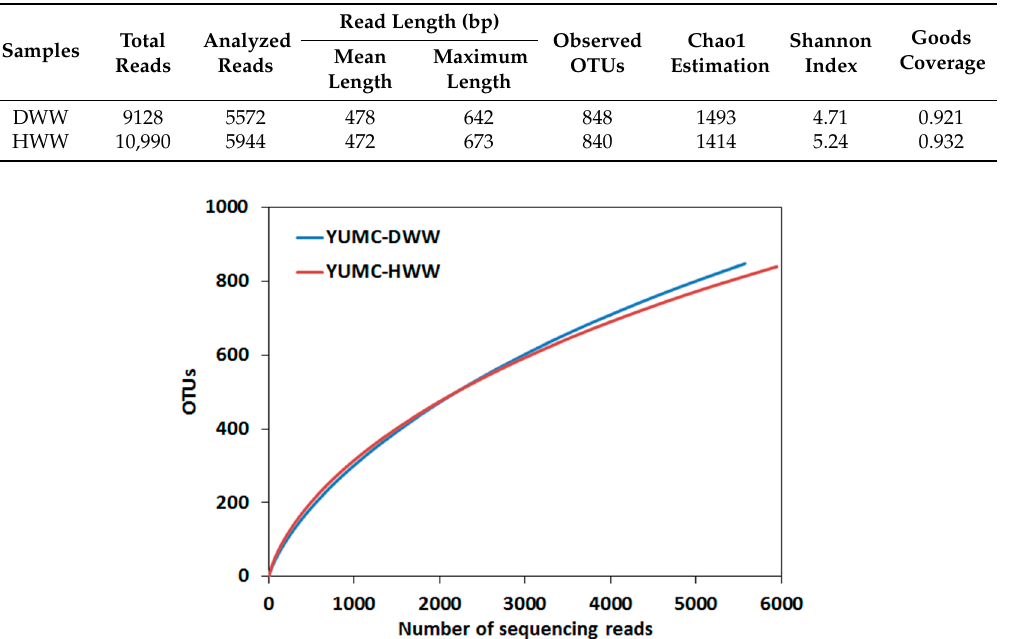
Table 1. Summary of pyrosequencing: richness and diversity of the bacterial phylotypes.